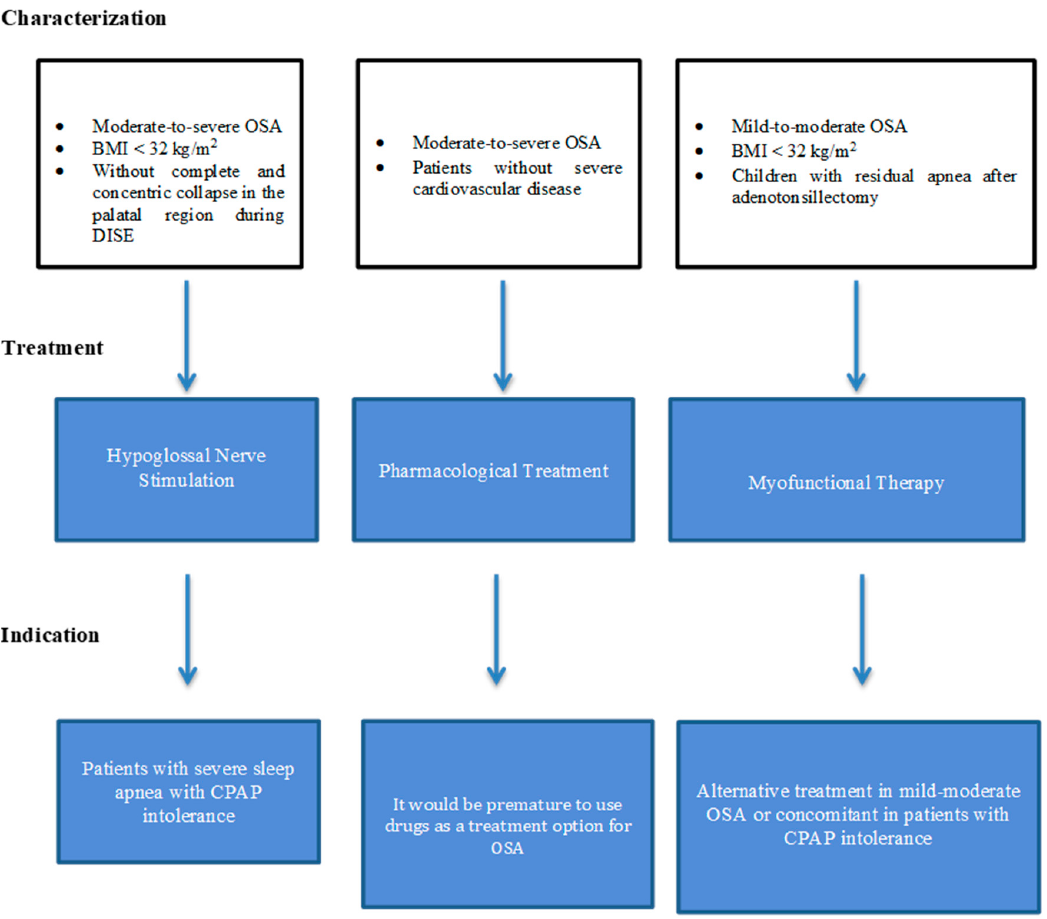
Figure 9. Alternatives to continuous positive airway pressure (CPAP) treatment: a diagram suggesting a phenotype-based treatment for adult obstructive sleep apnea patients and possible indications. OSA: obstructive sleep apnea; CPAP: continuous positive airway pressure; BMI: body mass index. Table 1. Summary of the main results in OSA-GG treatment and conclusions.